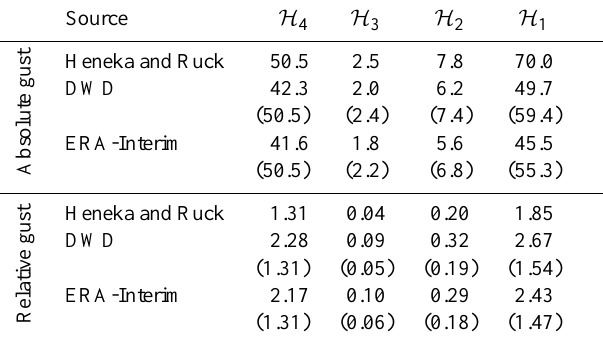
Table A1. Comparison of the parameter values obtained for the fed- eral state of Baden-Württemberg with those published by Heneka and Ruck (2008). Accordingly, relative wind gust speed was nor- malised by its 98th percentile. For easier comparison, the values in brackets are rescaled to match the published value of H 4